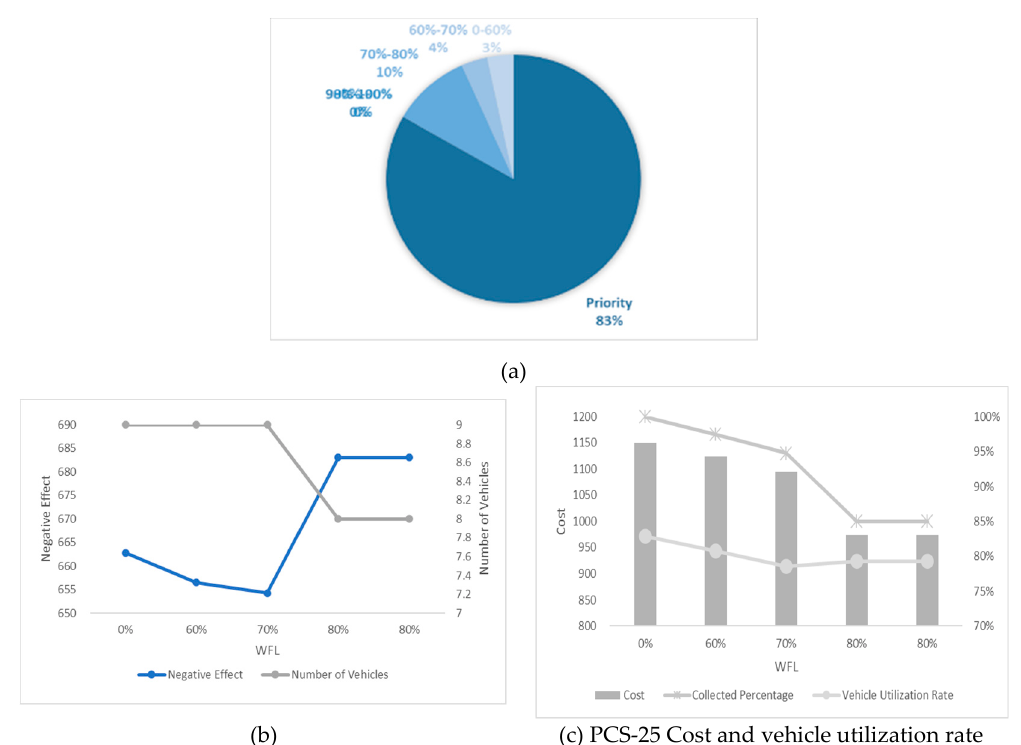
Figure 15. Results with 20 high-priority waste bins. ( a ) PCS-20 distribution of various waste bins, ( b ) PCS-20 negative effect and number of vehicles and ( c ) PCS-20 cost and vehicle utilization rate.